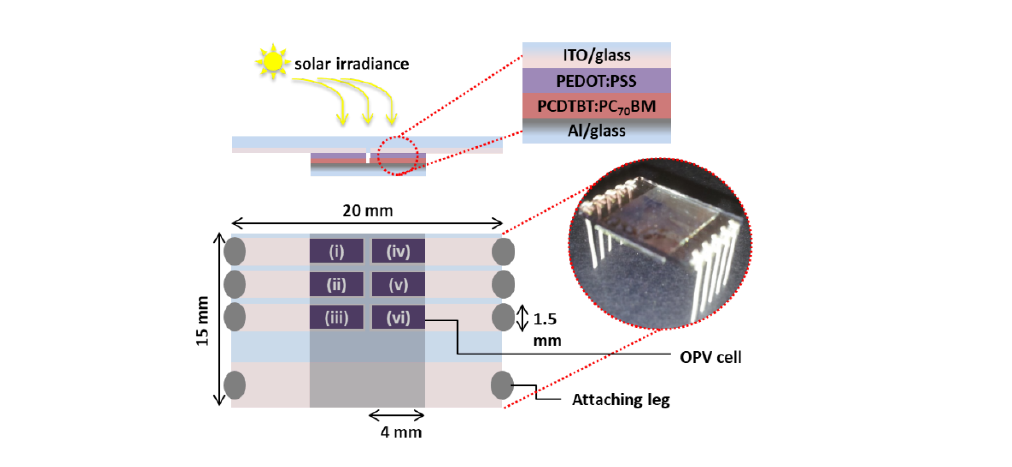
Figure 2. Patterned substrate pack (Ossila, UK) used for the fabrication of PV cells as shown in the example above.